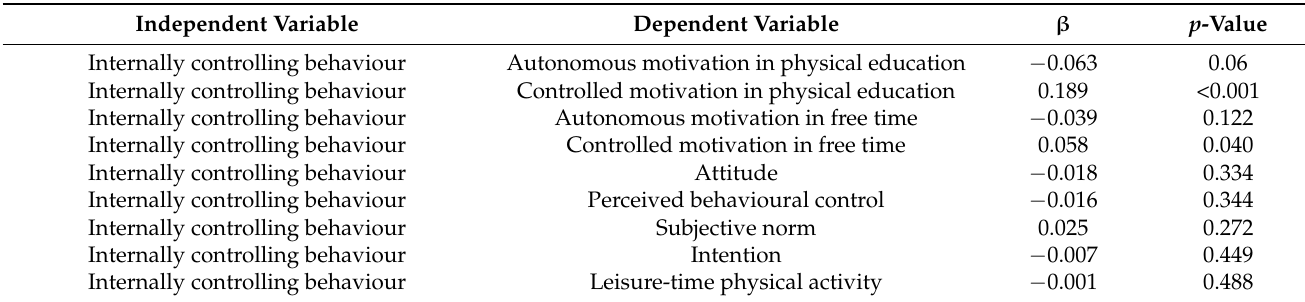
Table A1. Standardized indirect relationships between study